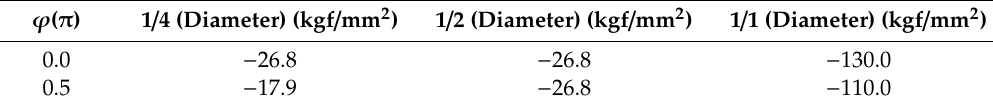
Table 2. Calculated values of stress with the measured birefringence.